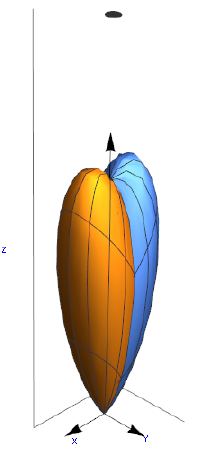
Figure 5. Target and left/right (L/R) beams’